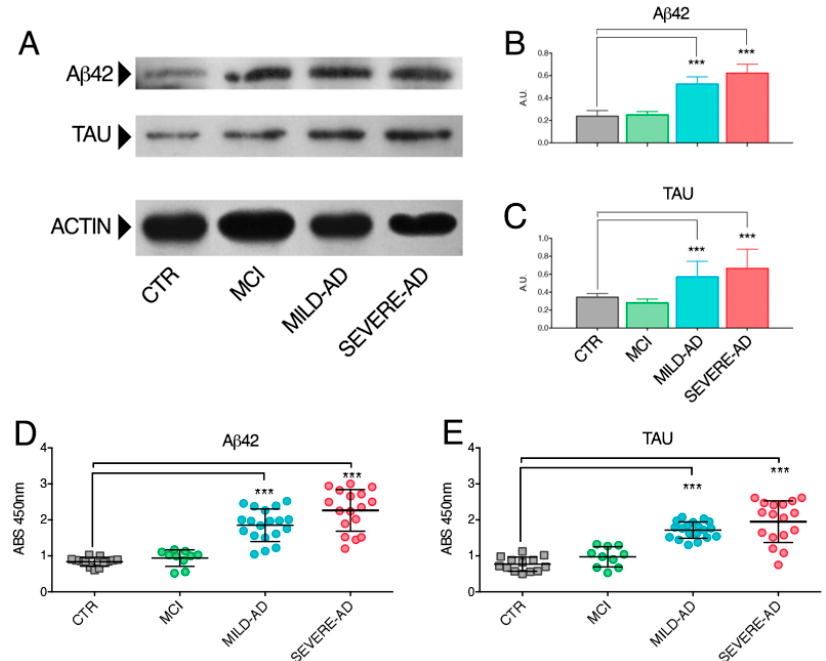
Figure 1. PBMCs from AD patients have primary hallmark of the disease: ( A ) Representative Western blotting of β -amyloid and Tau proteins analysis in PBMCs of mild AD, severe AD, MCI, and control subjects; ( B , C ) Densitometry analyses of both proteins were performed by the Fiji software (see Methods for details) and are reported as ratio toward β -actin protein, selected as reference. Each histogram is the mean ± SEM (standard error of the mean) of all samples analyzed in each group: CTR ( n = 13); MCI ( n = 10); mild AD ( n = 19); and severe AD ( n = 17); ( D , E ) Levels of β -amyloid and Tau proteins were determined in all samples of control group, MCI, mild AD and severe AD patients by using the ELISA assay. Results were expressed as the mean ± SEM of three independent experiments, each in triplicates. *** p < 0.001.